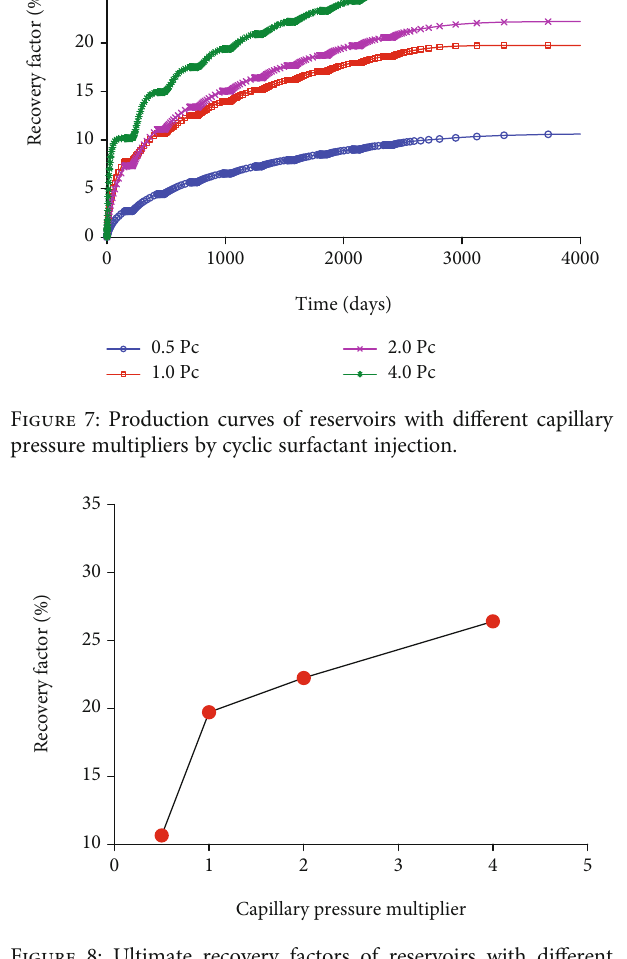
Figure 6: Ultimate recovery factors of reservoirs with di ff erent matrix permeabilities by cyclic surfactant injection.